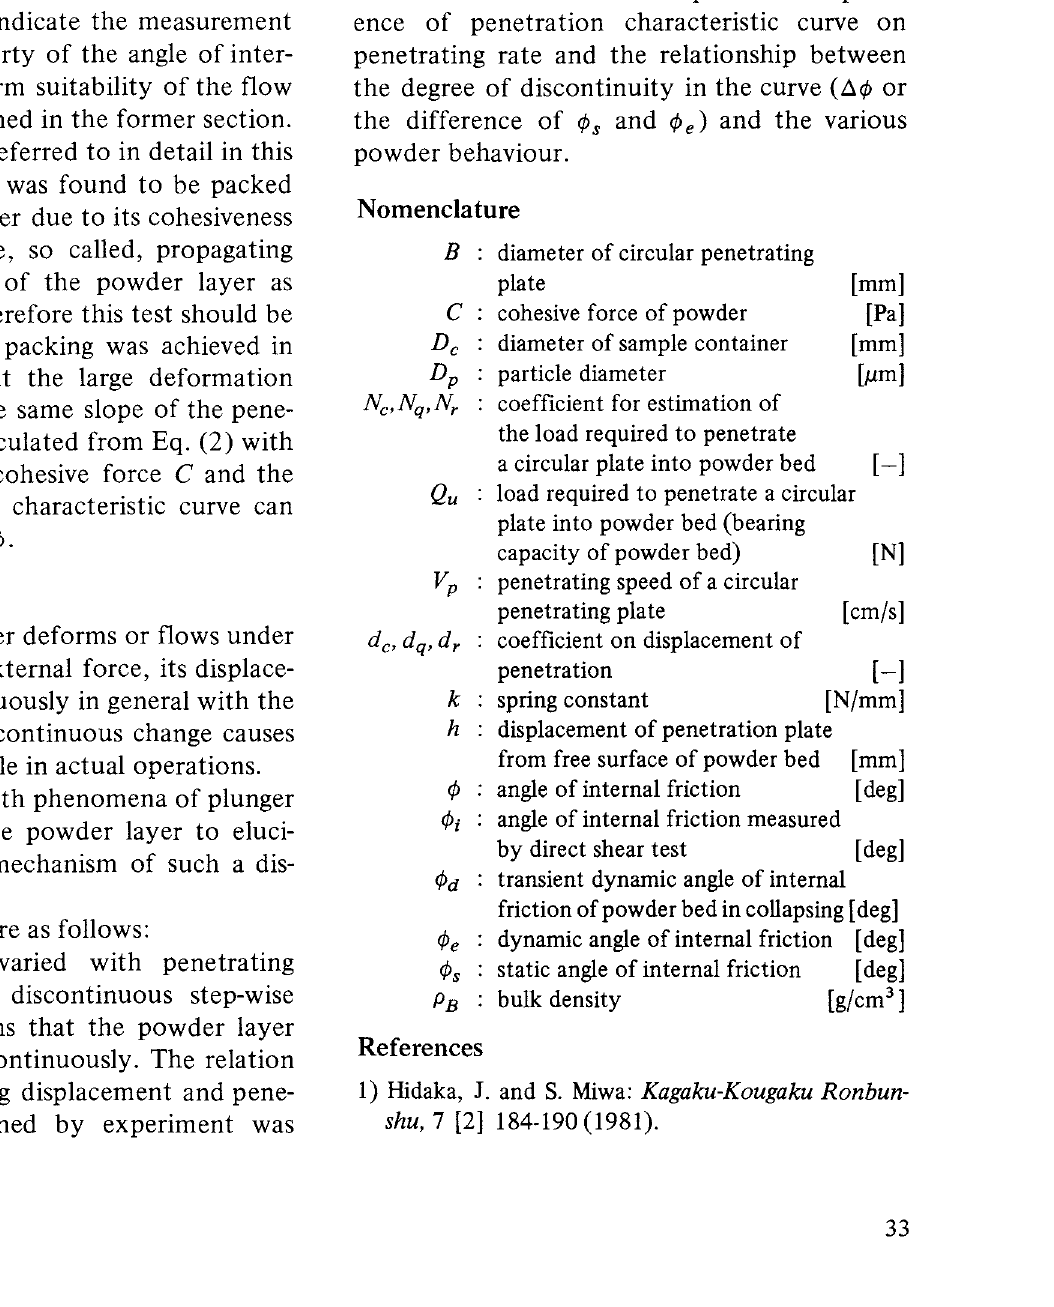
Fig. 1 7 Typical penetration characteristic curve of fine powder (white corundum